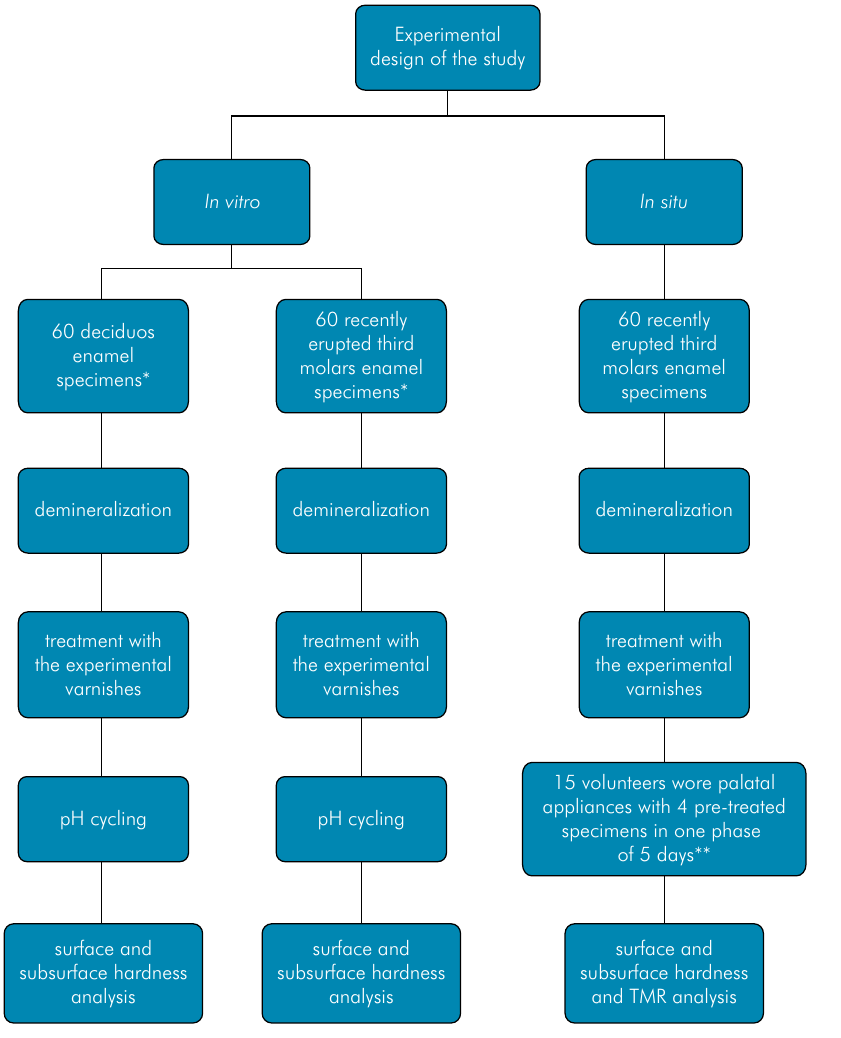
Figure 1. Experimental design of the